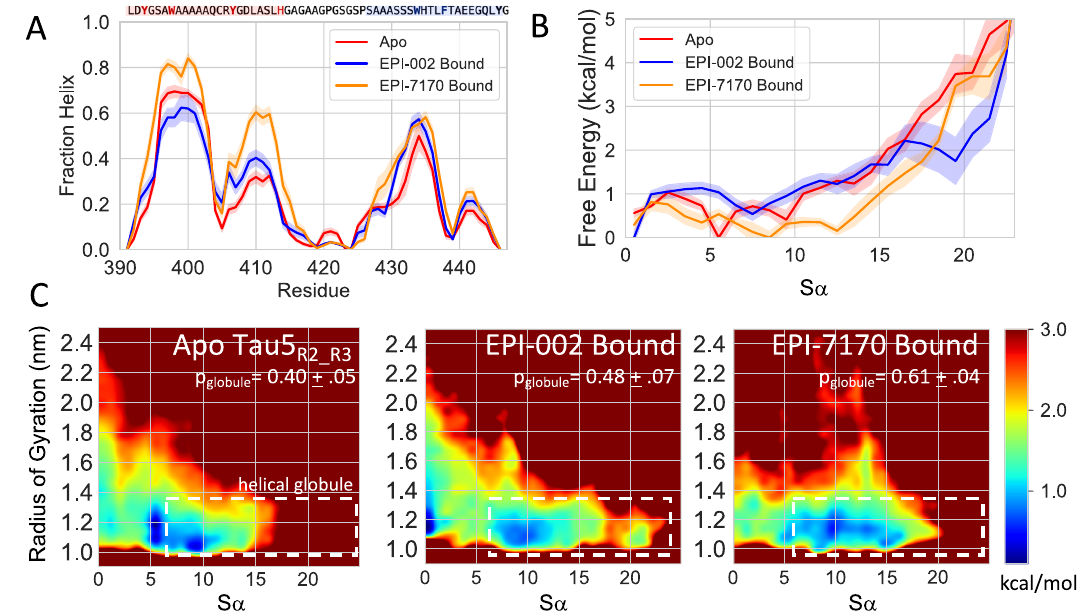
Fig. 3 | EPI-002 and EPI-7170 binding induces the formation of collapse helical states of the Tau-5 R2_R3 region of the androgen receptor N-terminal transacti- vation domain. A Helical propensities were observed in the 300K replica of explicit solvent REST2 MD simulations of Tau-5 R2_R3 in its apo form (red) and in bound conformations obtained from simulations run in the presence of EPI-002 (blue)andEPI-7170(orange).Simulatedhelicalpropensitiesarepresented asmean values±statistical error estimates from blocking. B Free energy surface of Tau- 5 R2_R3 conformations at 300K as a function of the helical collective variable S α for each ensemble.S α describesthe similarity ofallconsecutive six-residue fragments